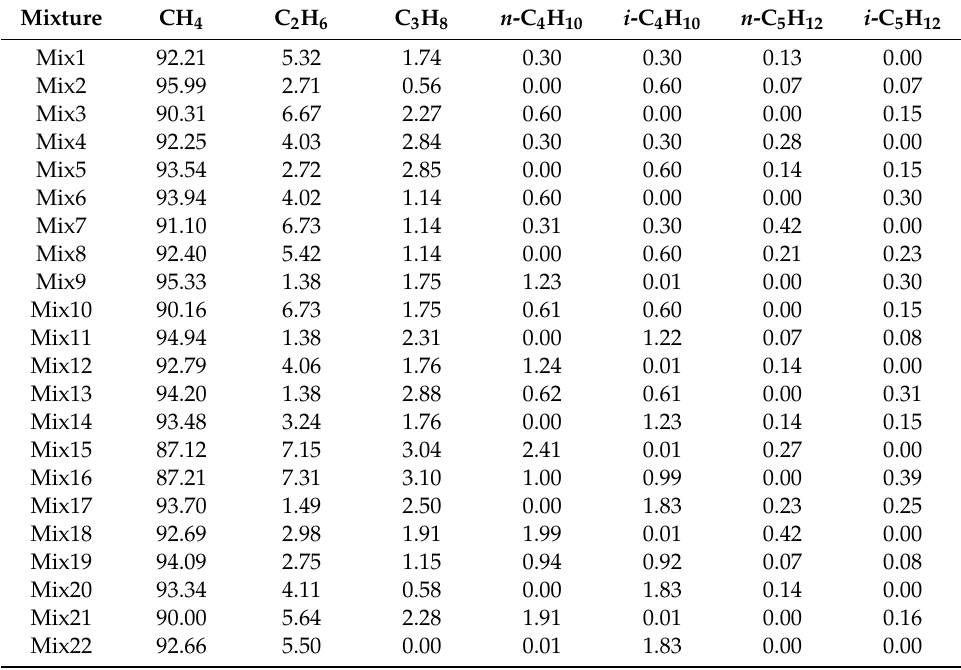
Table 2. Gas mixtures and concentrations (in vol.% as measured by the gas chromatograph) of the calibration